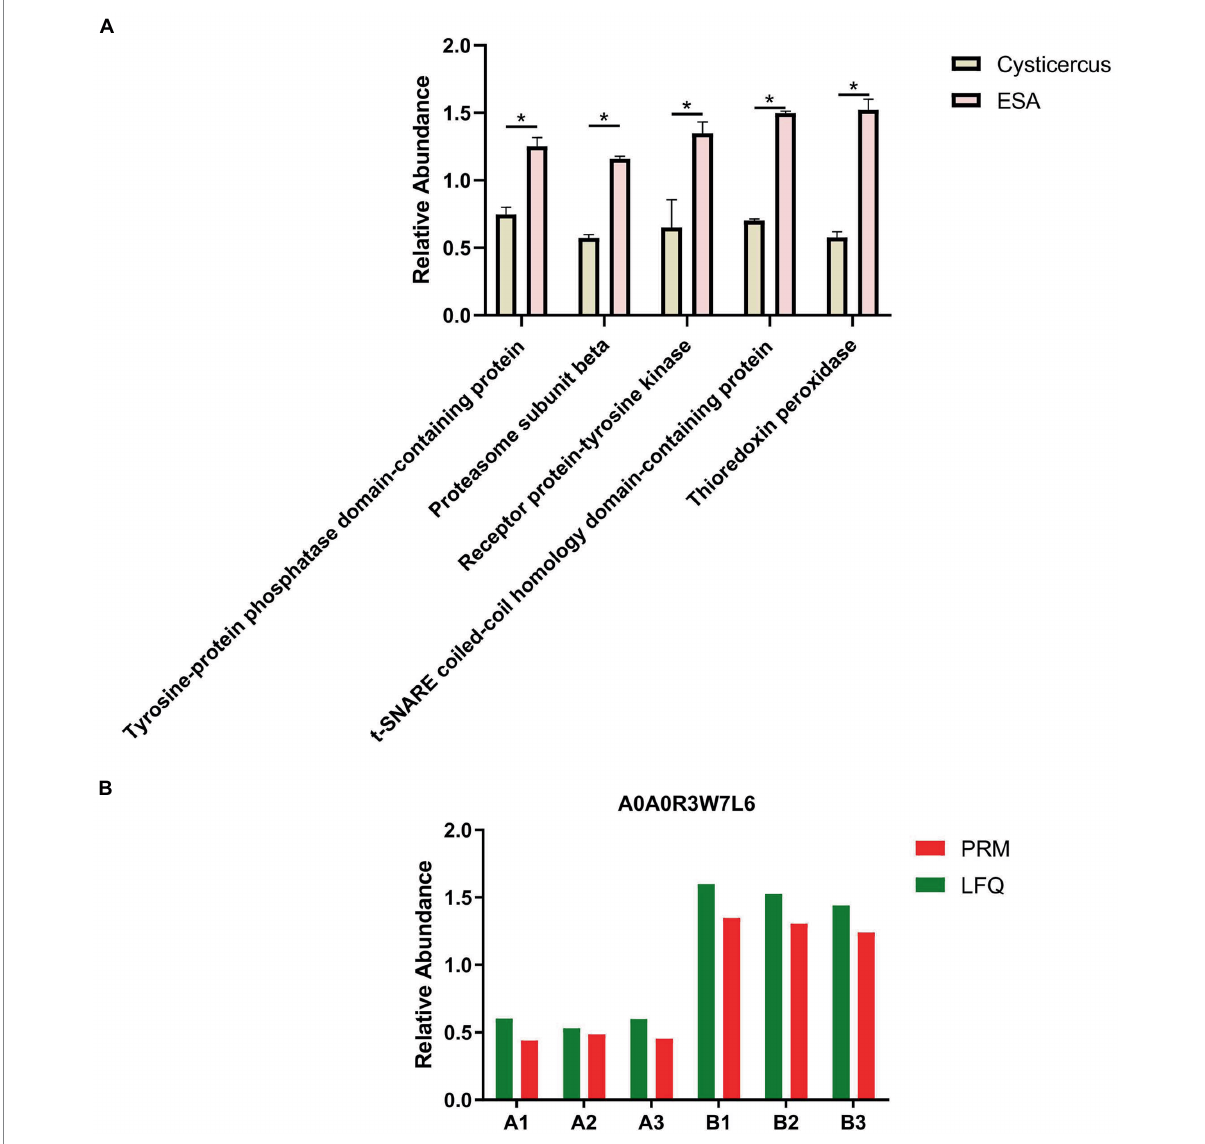
FIGURE 1 Screening and validation of TPx protein. (A) Statistical plots of the differential expression of five proteins, among which the TPx protein had the largest differential expression; (B) The change in the trend of TPx protein expression between the label-free quantification and parallel reaction monitoring results was consistent. * p <